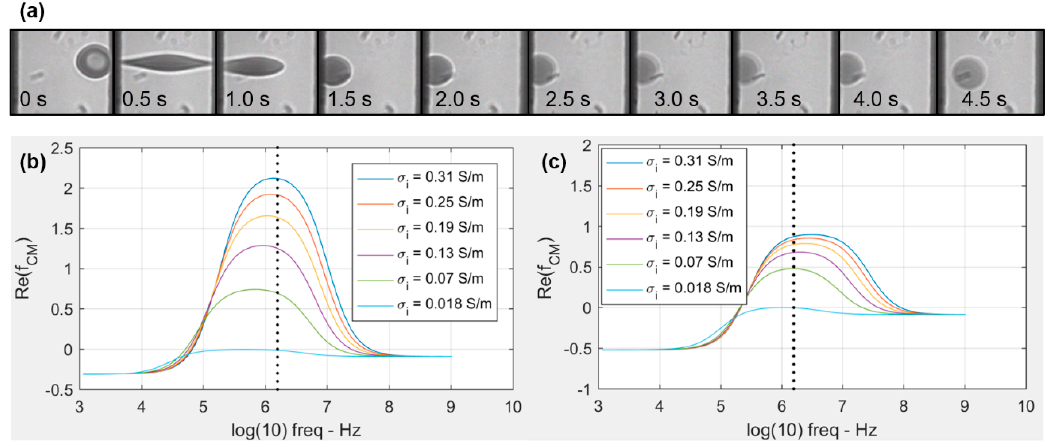
Figure 7. Release of hemoglobin from erythrocytes upon the coupling of membrane electrical breakdown and the electromechanical tensile stress. ( a ) Time elapse of a representative erythrocyte in response to 7 V rms excitation. ( b , c ) Re ( f CM ) as a function of electrical frequency for erythrocytes with different interior electrical conductivity, using ellipsoid and spherical models of the same volume, respectively. The three principal axes of the ellipsoidal erythrocyte were assumed to be 5 μ m, 1.5 μ m, and 1.3 μ m, respectively. The dashed line indicates the excitation frequency of 1.58 MHz used in this study.